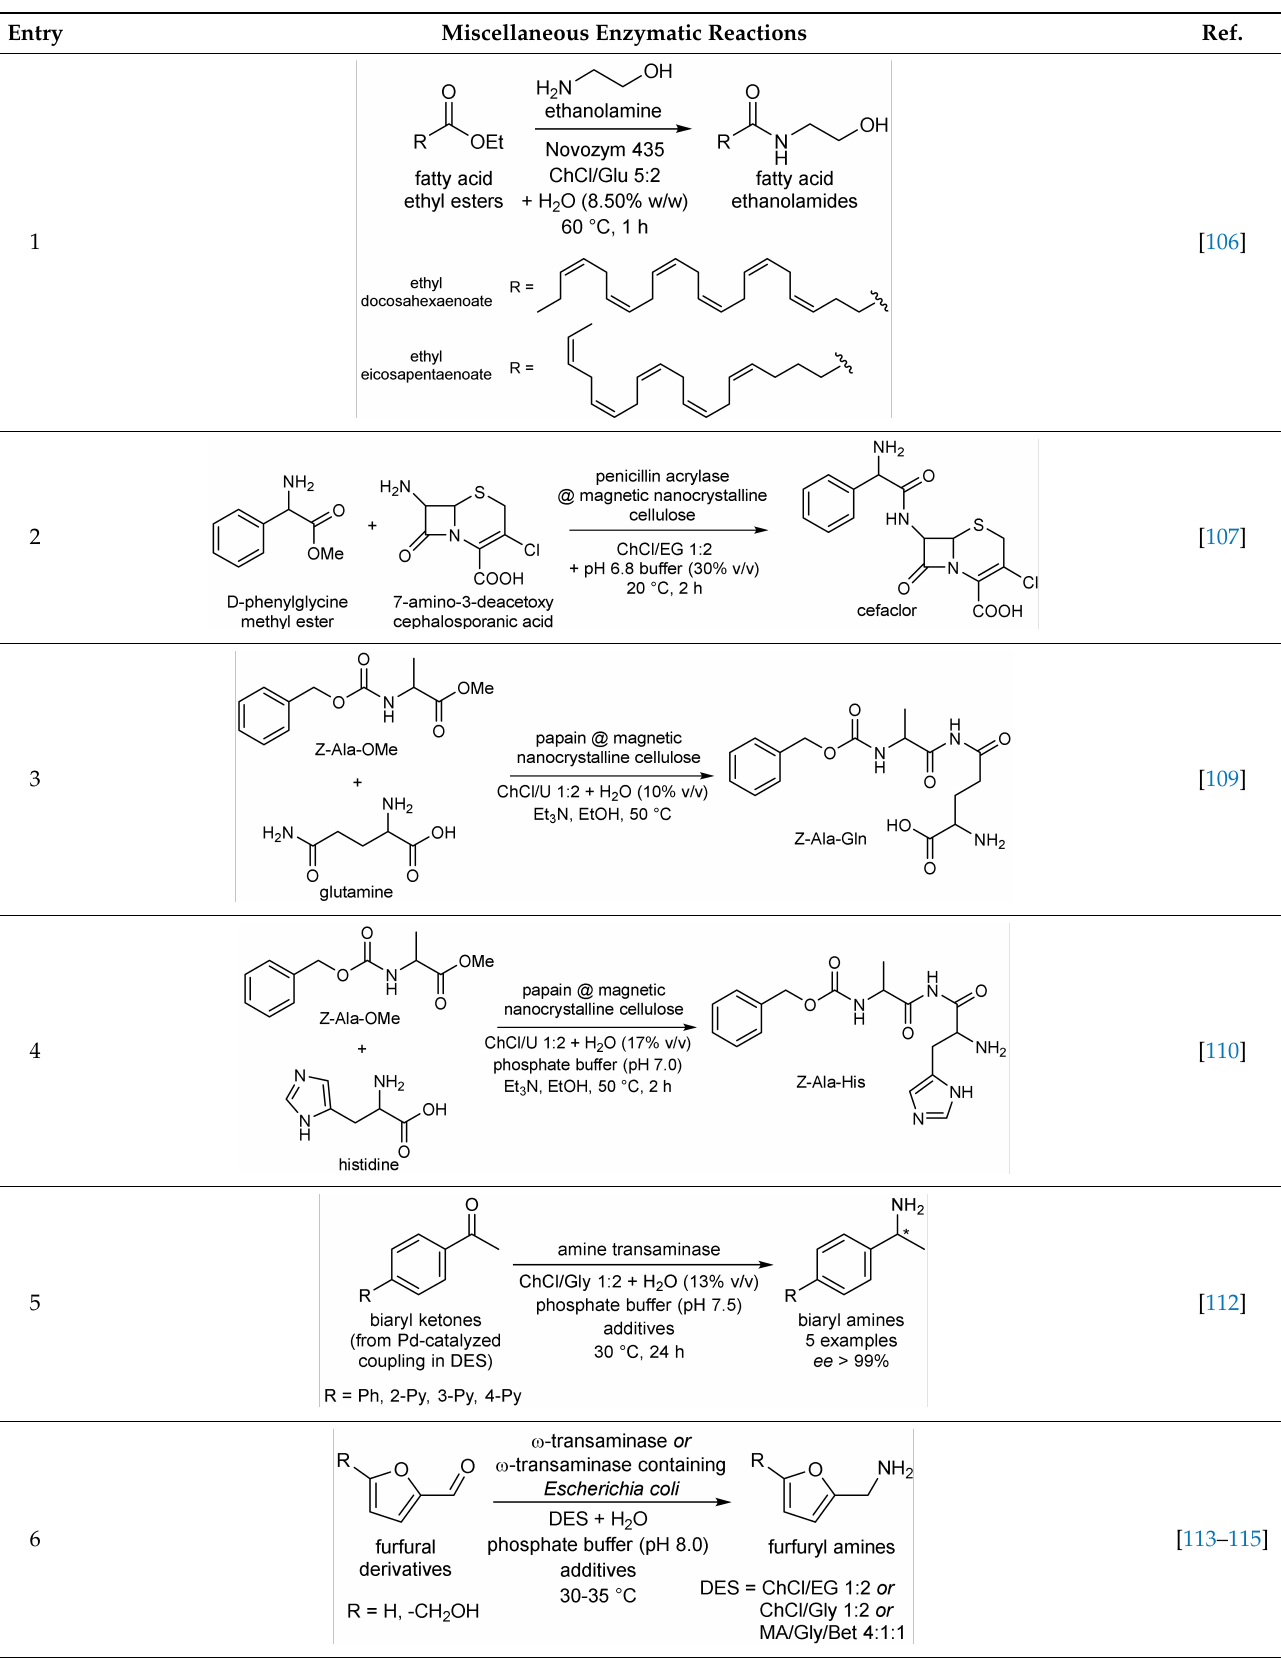
Table 9. Miscellaneous enzymatic